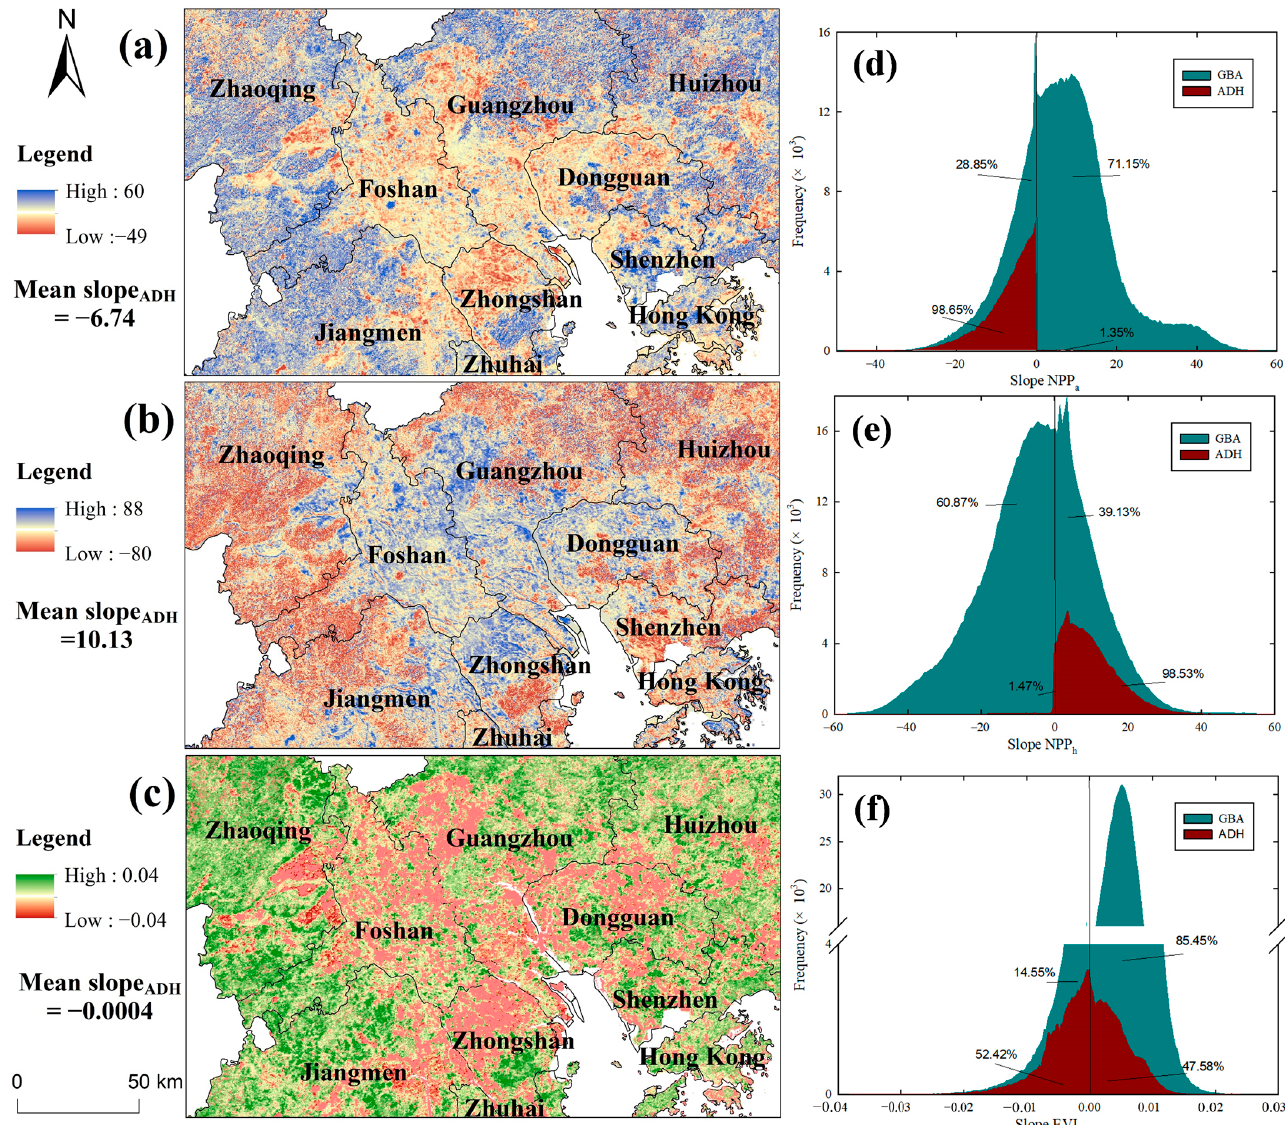
Figure 10. Trends in annual ( a ) NPP a , ( b ) NPP h , and ( c ) EVI from 2000 to 2020 in the areas where NPP a was negatively influenced by human activities (ADH), and corresponding frequencies of ( d ) slope NPP a , ( e ) slope NPP h , and ( f ) slope EVI values.